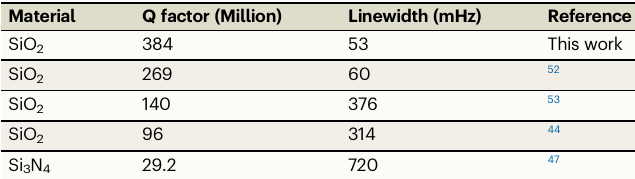
Table 1 | Comparison of SBL fundamental linewidth Material